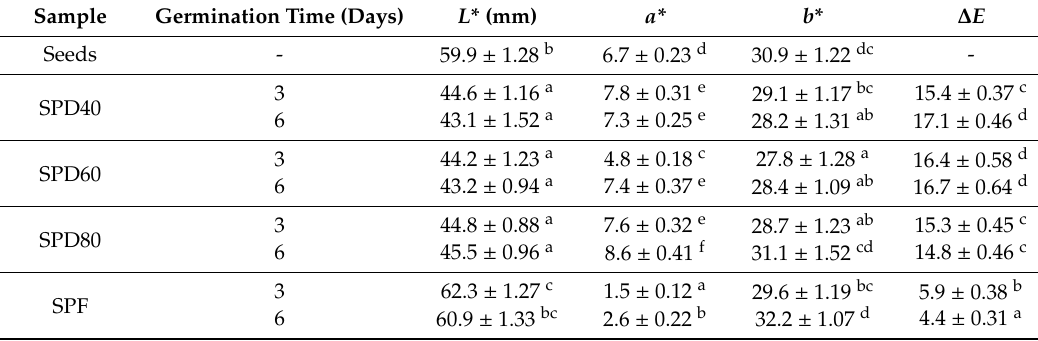
Table 4. Color coordinates of the ground seeds and sprouts and total color di ff erence ( ∆ E